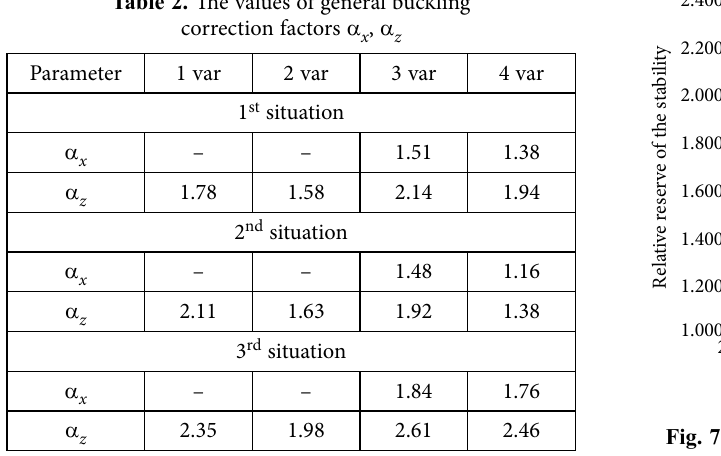
for three situations